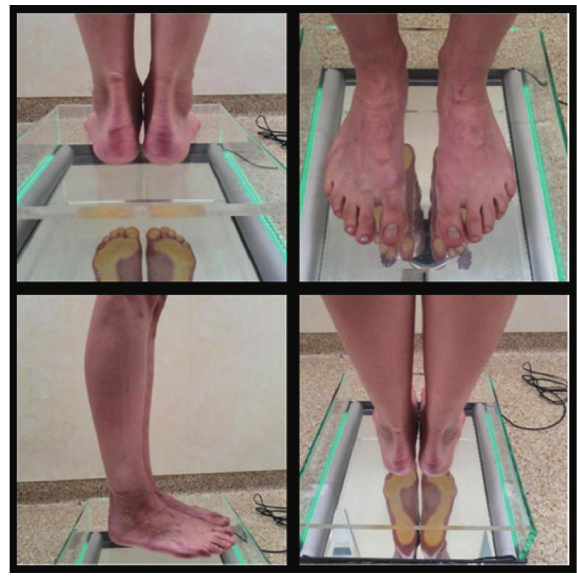
Figure 3: A visual examination of an exemplary patient using a podoscope.